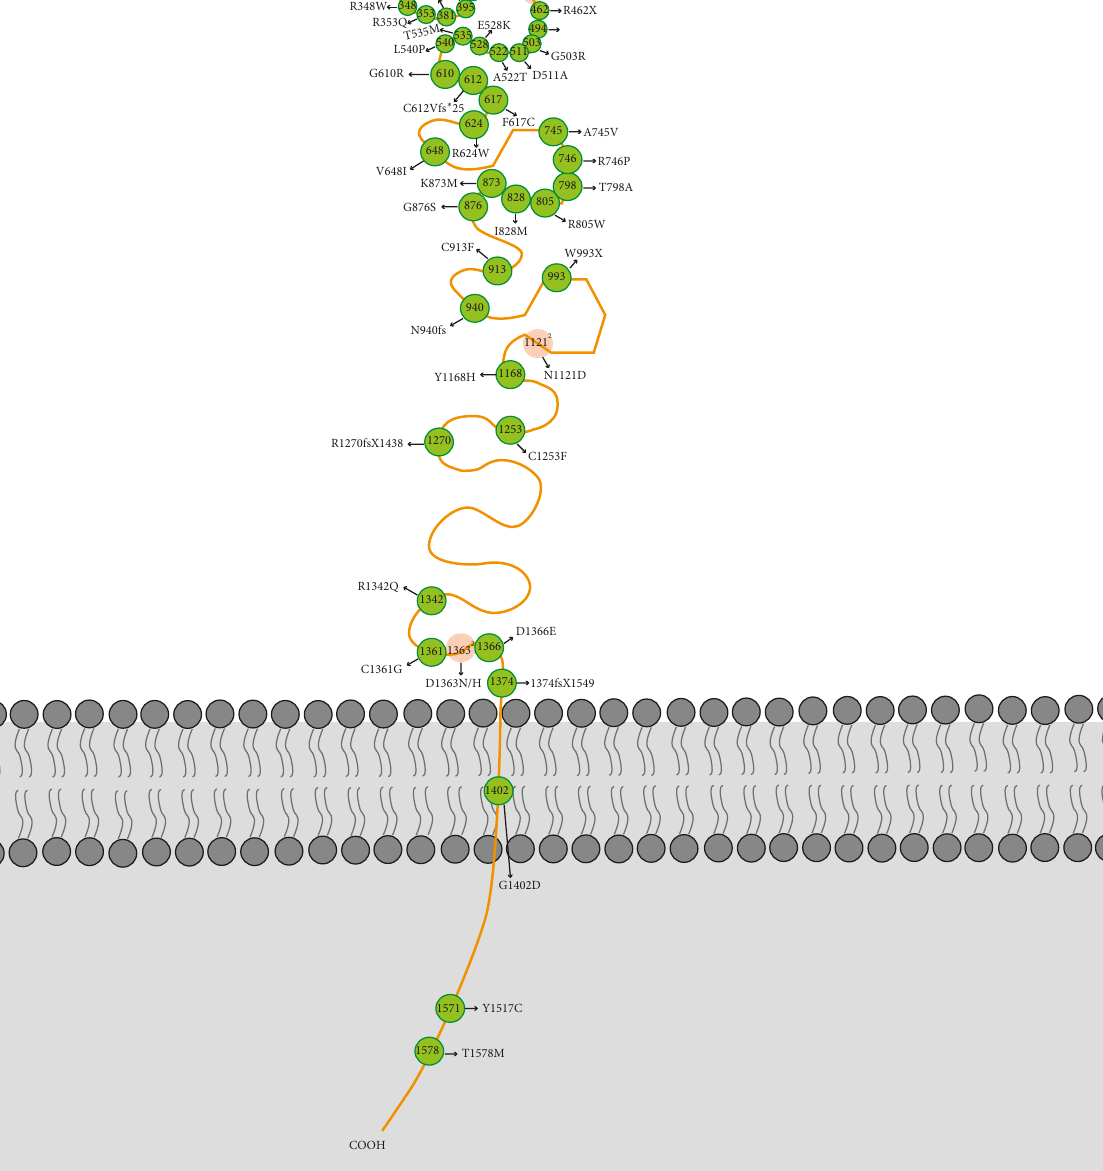
Figure 4: Schematic representation of LRP5 protein shows the location of the mutations within the protein domains. Four splice site mutations are not shown. Superscript number means the reported times of the same or different mutations at a certain site. The color of the mutations which were reported more than one time was recolored as orange. The opacity varied with the reported frequency of the